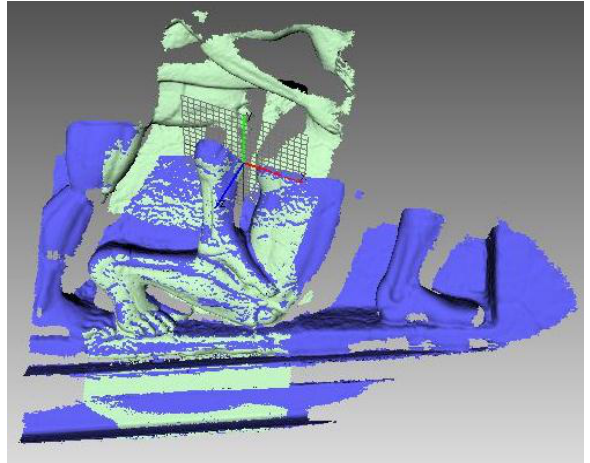
Figure 9. ICP for the Metope scans